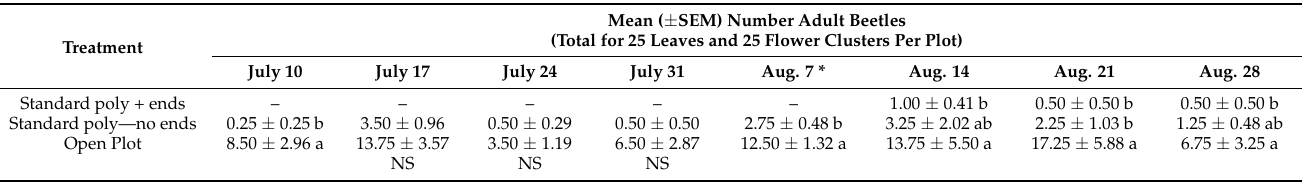
Table 3. Mean adult P. japonica counts in high tunnels covered with plastic and netting used for pest exclusion, ‘Heritage’ raspberry, Rosemount, MN, 2019.